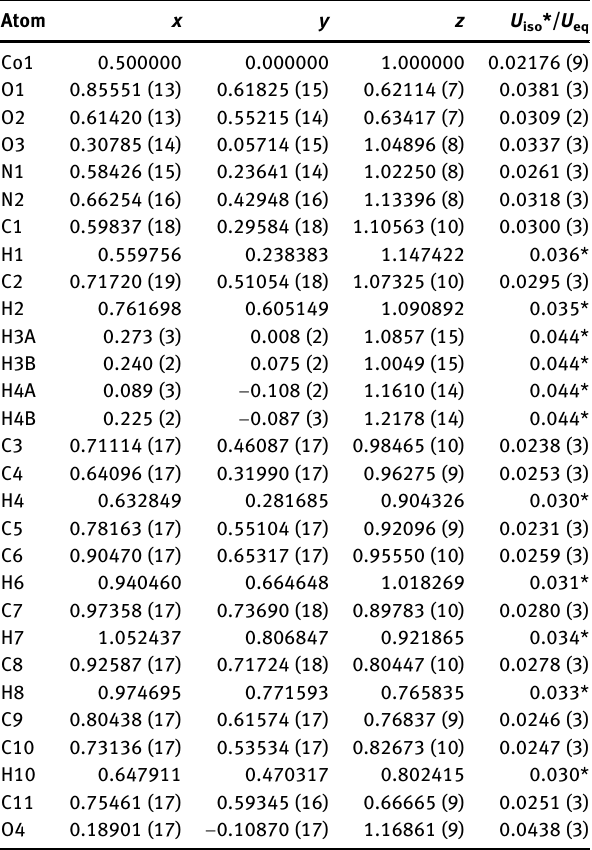
Table  : Fractional atomic coordinates and isotropic or equivalent isotropic displacement parameters (Å 